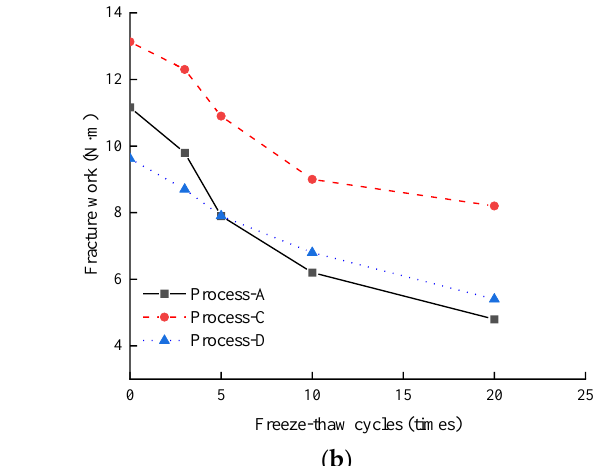
Figure 13. Relationship between fracture work and freeze – thaw cycles: (a) completely dry condition; (b) water saturation condition.